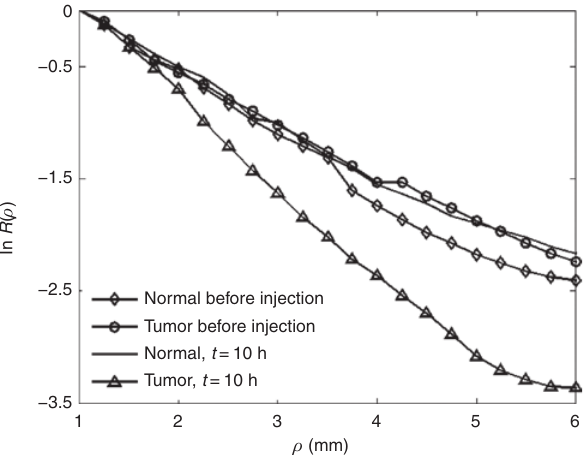
Figure 3: DR profiles of tumor bearing mice following GNR injection. Diffusion reflection profiles (in a semi-logarithmic scale, a.u) of healthy and tumor sites, in tumor bearing mice. Measurements were performed before the GNRs injection and 10 h post-injection. The sharpest curve is for the tumor, indicating the increase in the absorption properties of this site. The other, similar curves are for the DR measurements performed before the GNRs injection in both tumor and healthy sites (circled and diamond lines, respectively), and in the normal site after the GNRs injection (solid